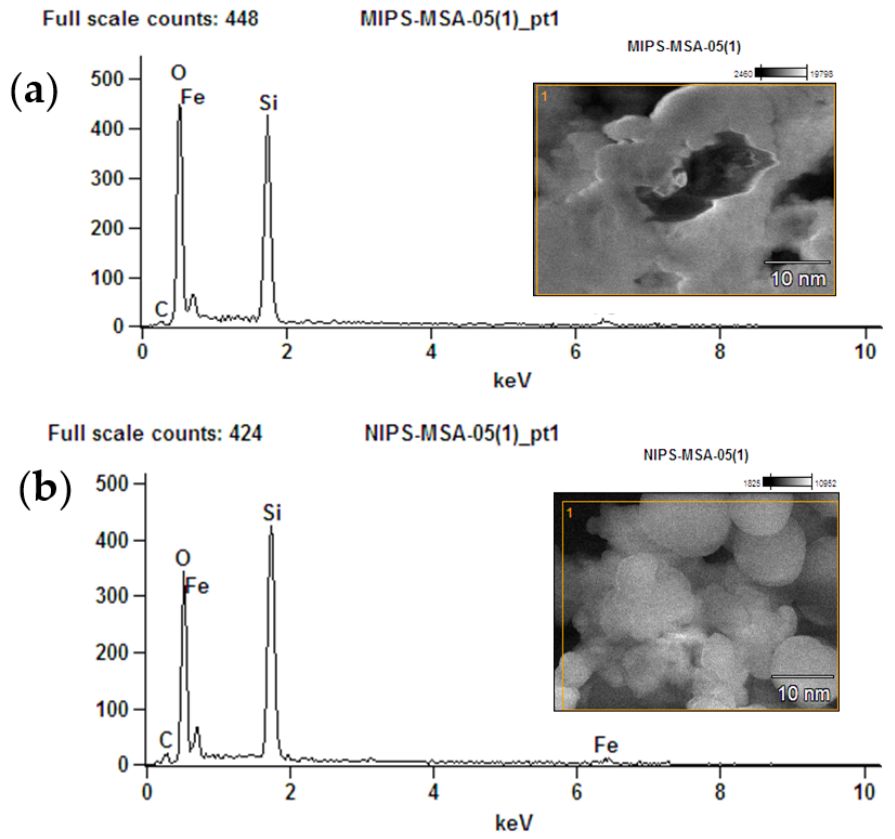
Figure 3. EDX analysis ( a ) MMIPs and ( b )